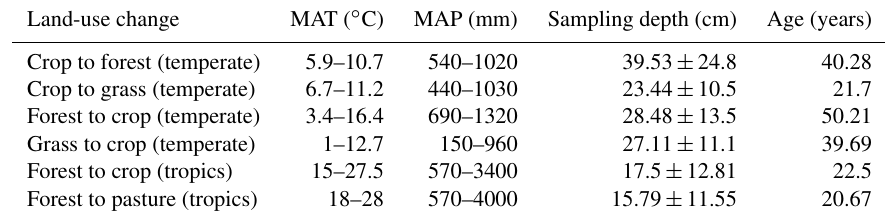
Table 1. Mean annual temperature (MAT) range, mean annual precipitation (MAP) range, mean sampling depths ( ± SD), and the mean current land-use age for the local-scale observations in the meta-analyses. We note that the different equilibrium results presented below, e.g., for crop in the crop-to-forest LUC and the forest-to-crop LUC, are due to the different climate criteria (precipitation and temperature) for the different